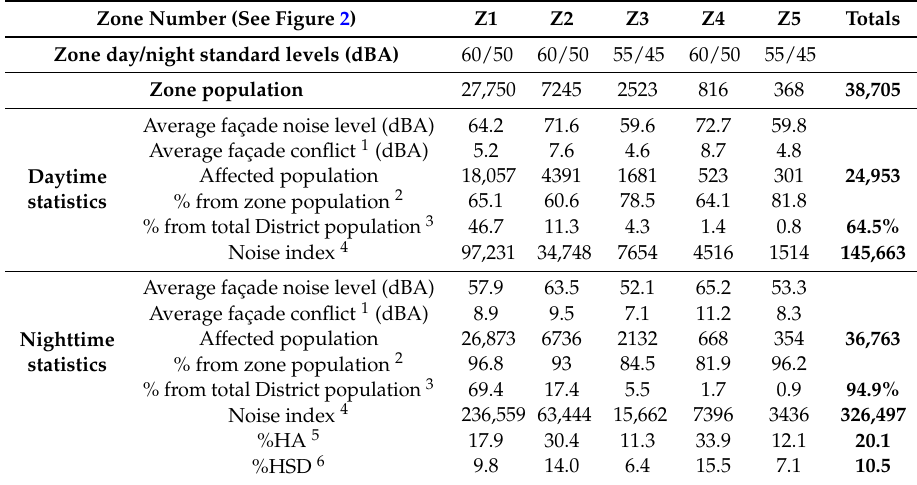
Table 3. Average noise annoyance statistics due to excess noise levels (LKZ method) and highly annoyed population at Al-Fayha